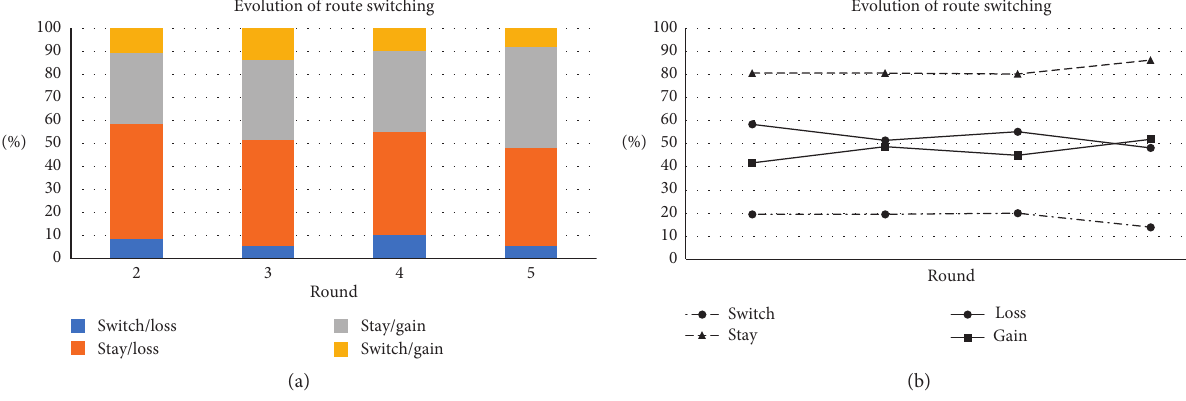
Figure 4: Evolution of route choice behavior under Scenario 2. (a) Probability of each state. (b) Propensity of each state.